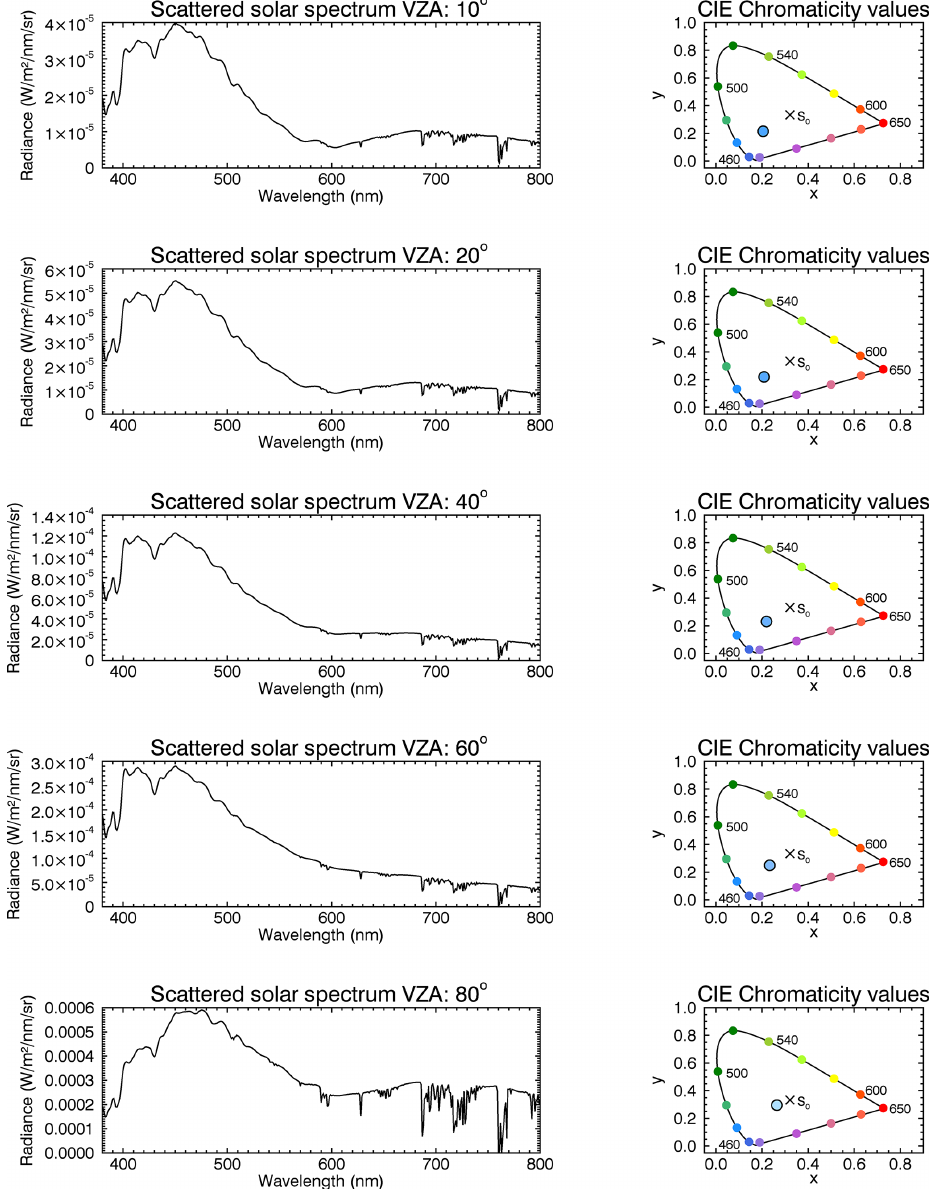
Figure 5. Solar scattering spectra (left column) and CIE chromaticity diagrams (right column) for an observer on the Earth’s surface and for a SZA of 98 ◦ and VZAs of 10, 20, 40, 60 and 80 ◦ (from top to bottom) and a SAA of 0 ◦ , including NLCs with an optical depth of 10 − 4 at an altitude of